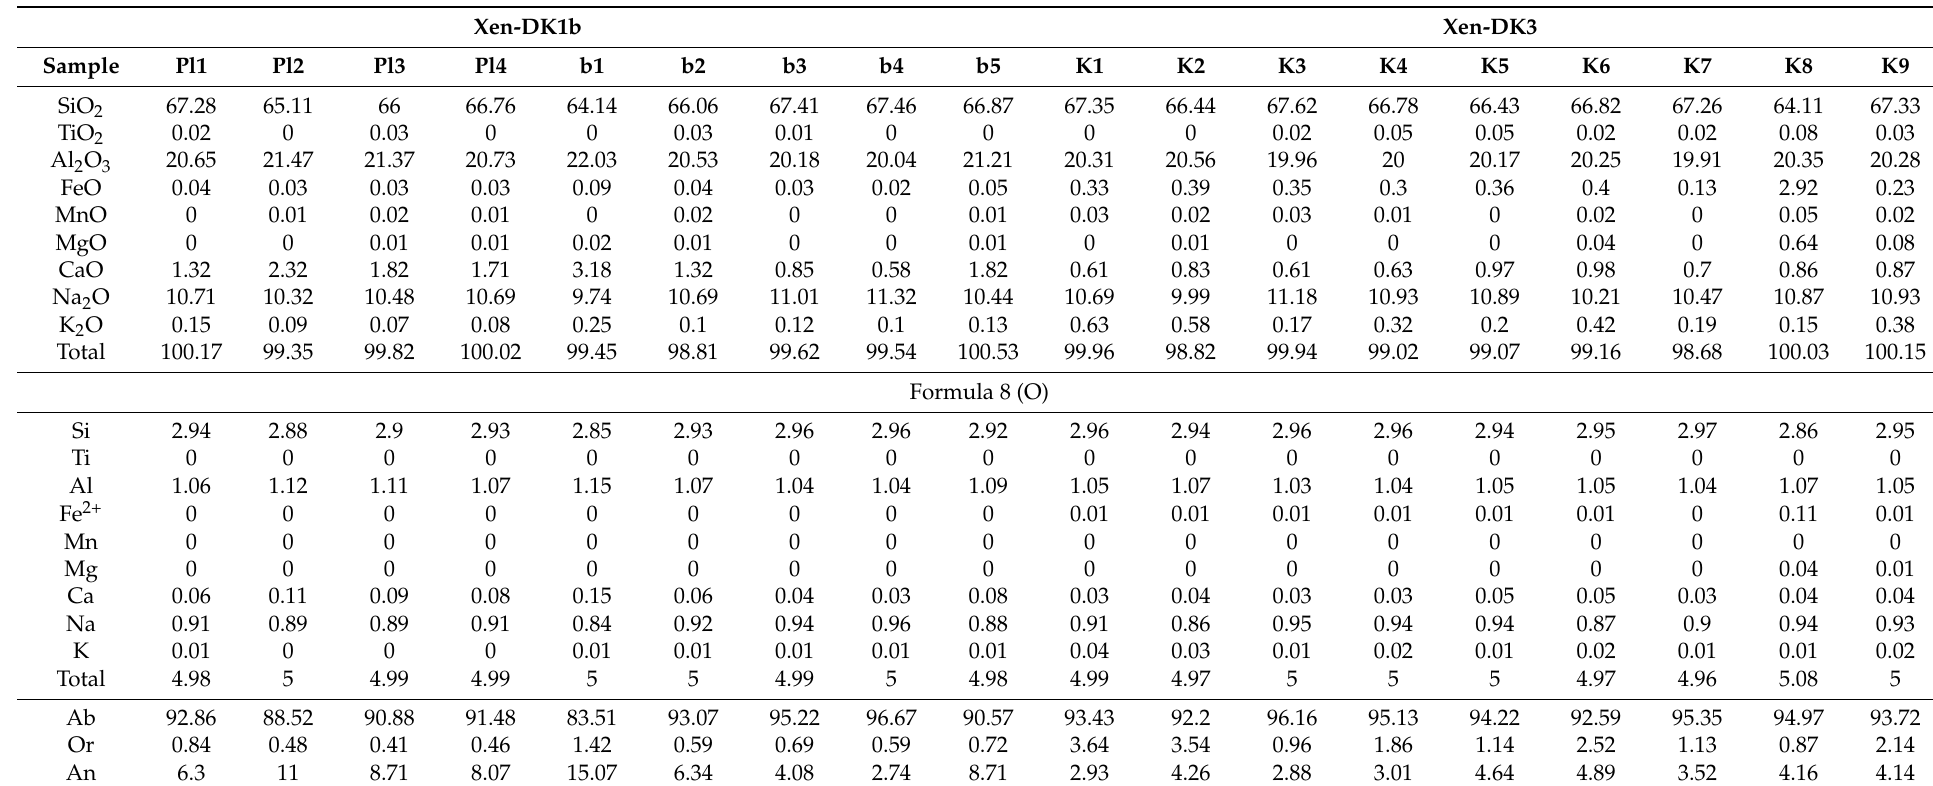
Table 1. Representative analyses of plagioclase from diorite and micro diorite